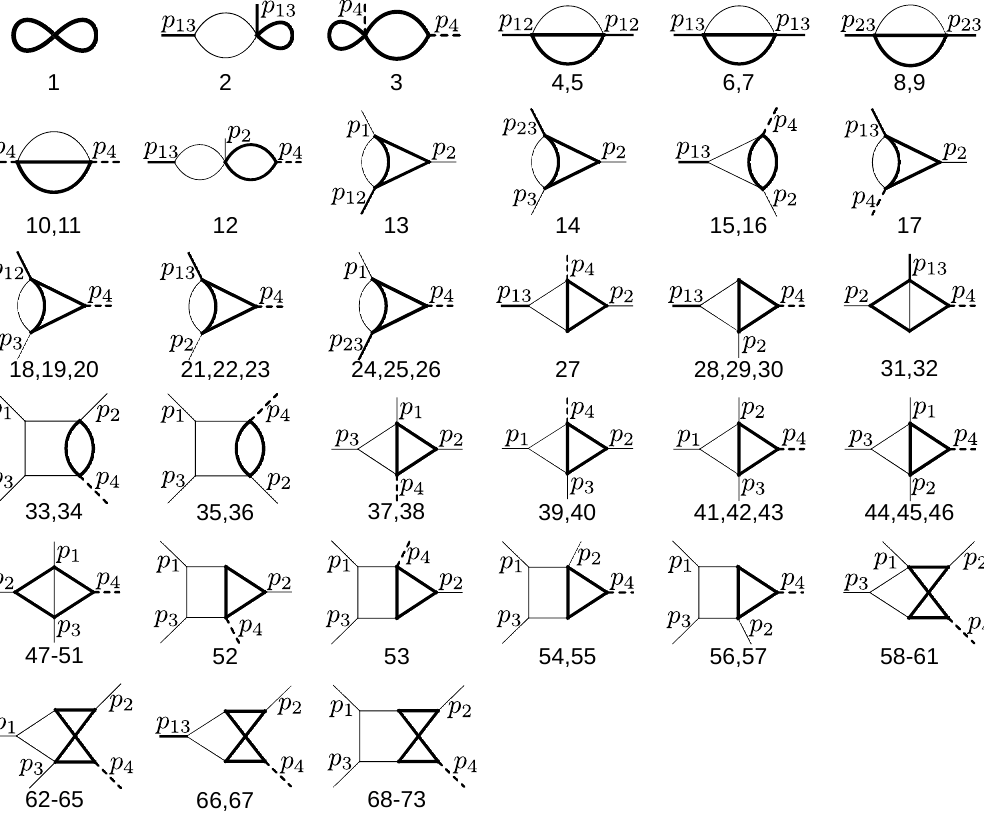
Figure 5 . The 73 master integrals. Shown on the (cid:12)gure is the sector, i.e. the set of propagators, to which the master integrals belong. Higher powers of propagators, numerators, or prefactors are not shown. External momenta are labelled using p ij = p 1 + p j and p 4 = p 1 + p 2 + p 3 . Masses (internal as well as external) are indicated with a thicker